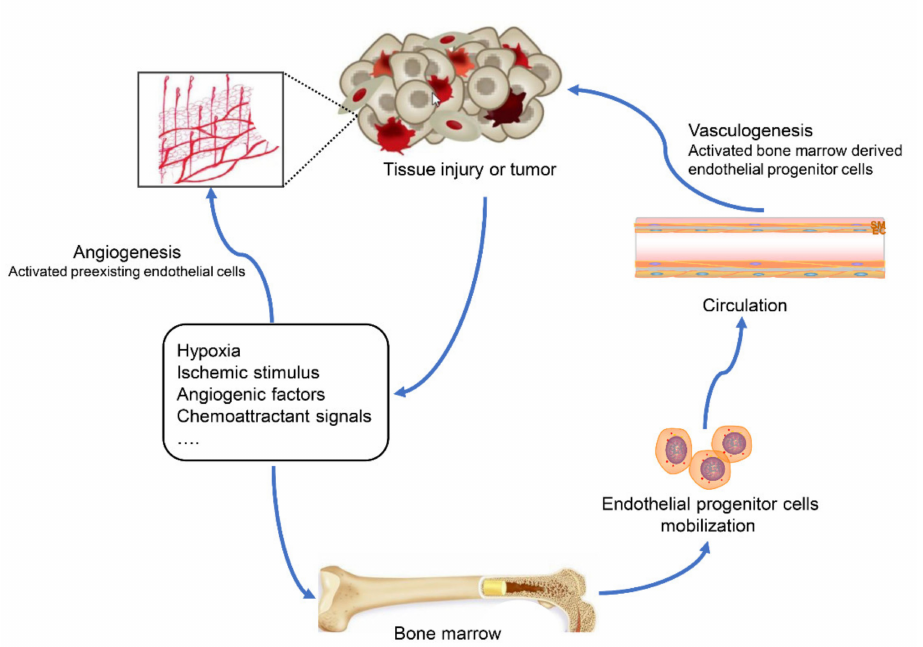
Figure 1. Graphic summarization of neovascularization evoked by tissue injury or tumor. Under the stimulation of hypoxia, ischemic stimulus, angiogenic factors and chemoattractant signals, the two main neovascularization processes are activated. Endothelial cells participate in angiogenesis and form new capillaries from local vessels; endothelial progenitor cells home to target tissues and contribute to primitive vessel